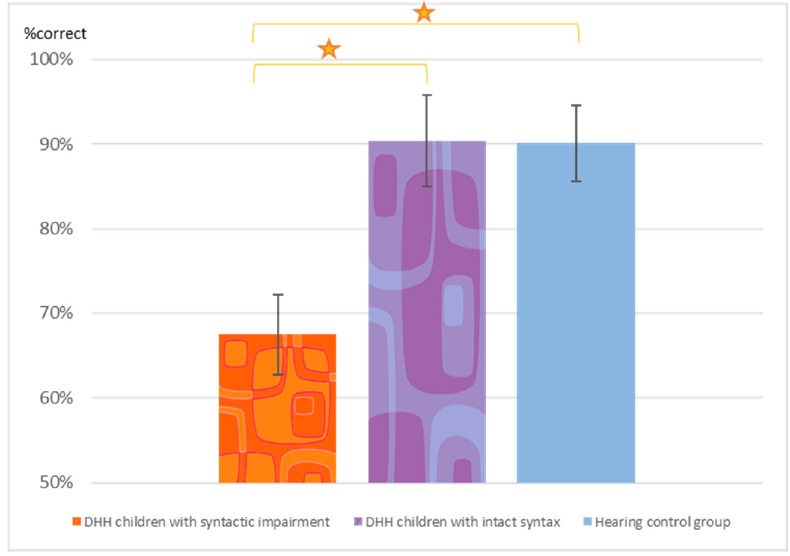
Figure 4. Percentage correct answers to the comprehension questions about the texts with movement. Pentagram: p < 0.0001. Star: p <